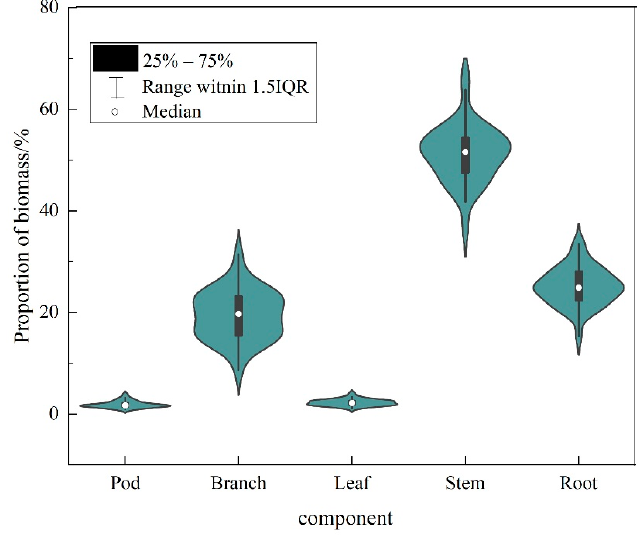
Figure 3. Biomass allocation of Robinia pseudoacacia L. IQR represents the interquartile range.